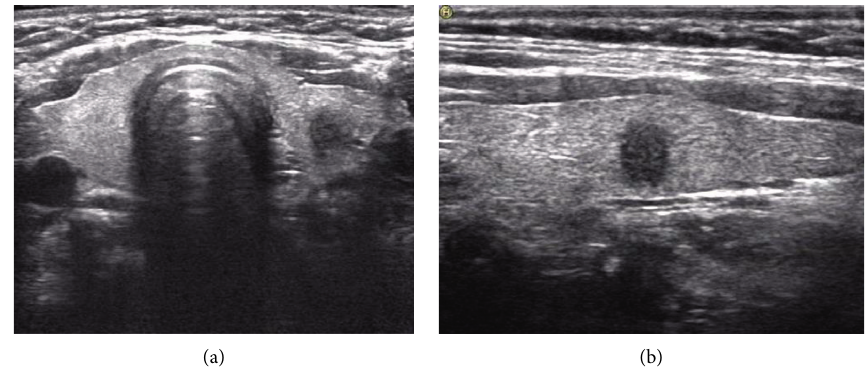
Figure 2: Ultrasonography of the nodules in papillary thyroid carcinoma (PTC) without central lymph node metastasis. The tumor is located in the middle of the left thyroid lobe, with a maximum diameter of 8mm, solid and very hypoechoic, aspect ratio > 1, and unclear margin. The American College of Radiology Thyroid Imaging Reporting and Data System (ACT TI-RADS) score was 8 points. (a) Transverse section; (b) longitudinal